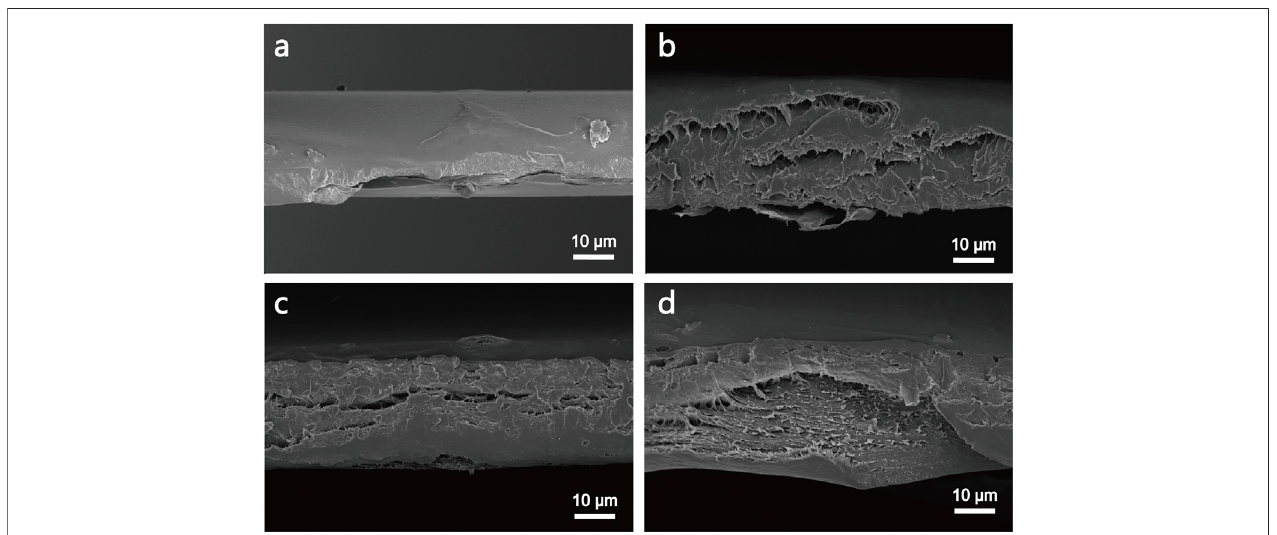
FIGURE 5 | SEM images of the cross-section of PVA (A) , PVA-N1 (B) , PVA-2%GO (C) , and PVA-N1-2%GO (D) .